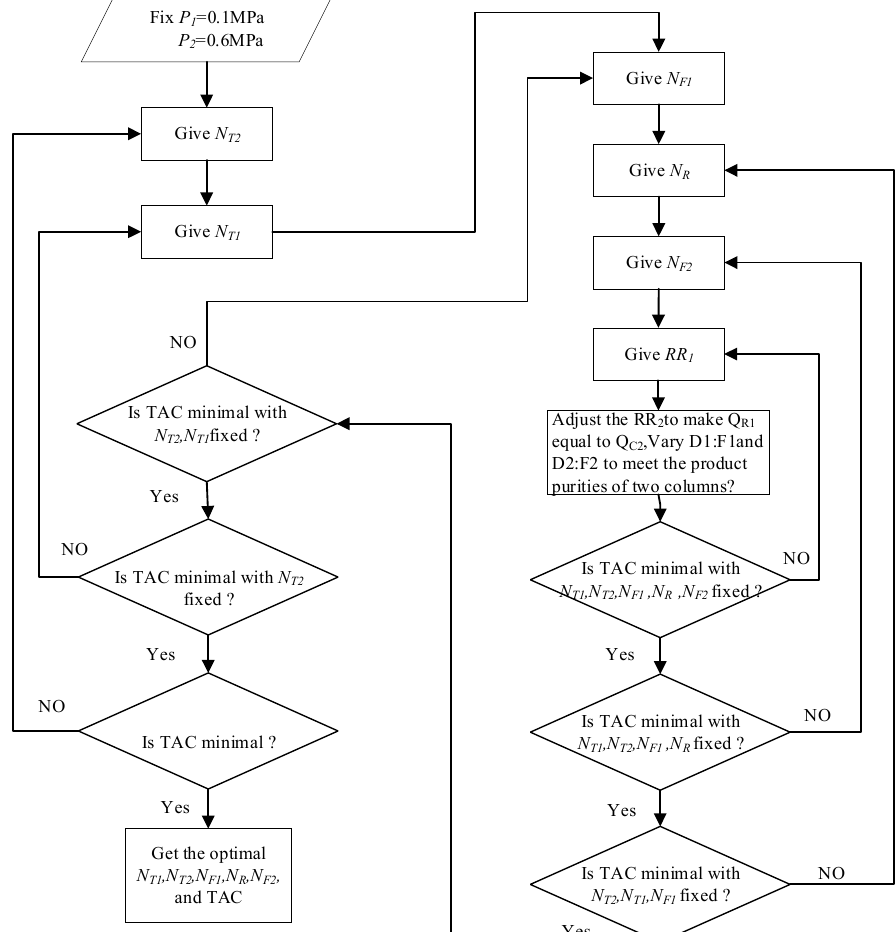
Figure 6. Sequential iterative optimization procedure for the fully HIPSD process.